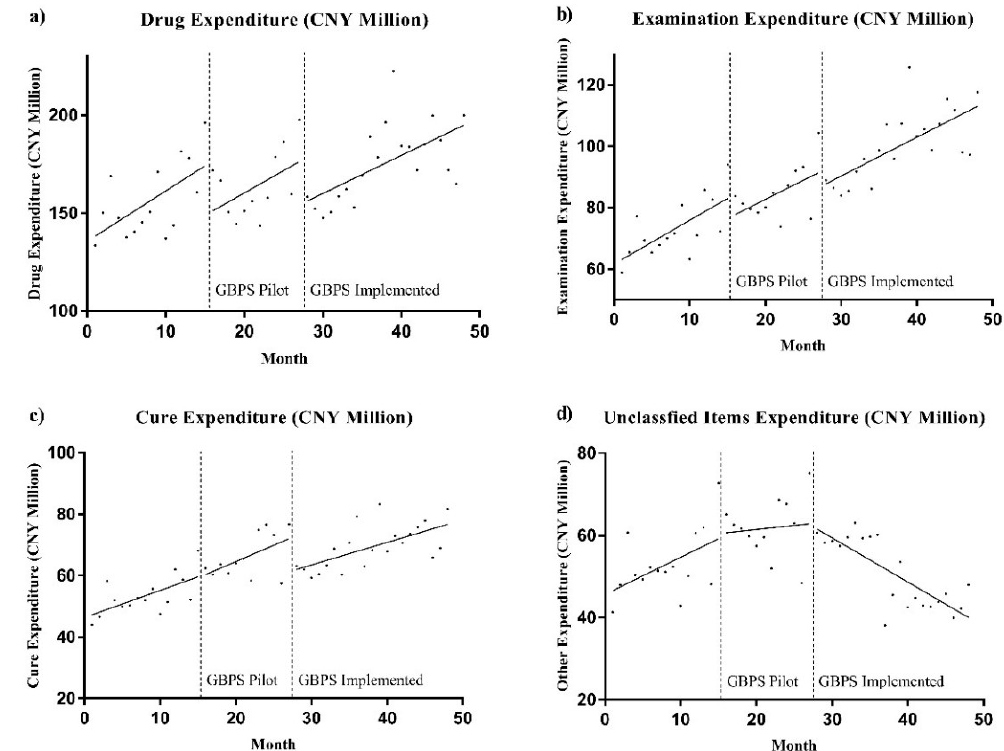
Figure 2. Monthly trend of different types of medical expenditure in study period.